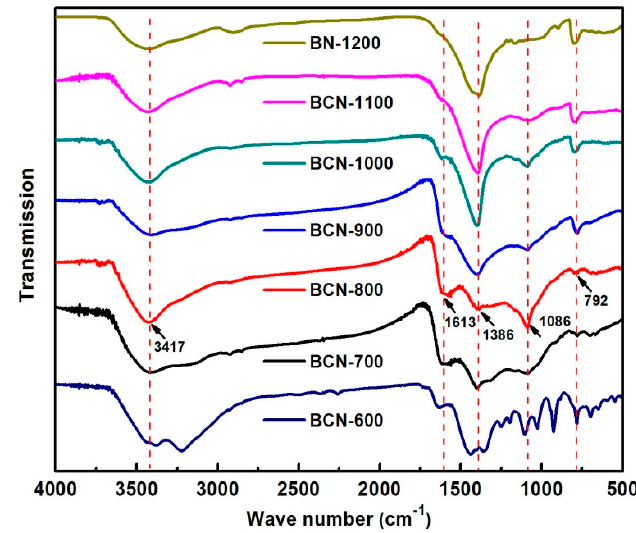
Figure 1. Fourier transform infrared (FTIR) spectra of boron carbonitride (BCN)-600, BCN-700, BCN-800, BCN-900, BCN-1000, BCN-1100, and BN-1200.